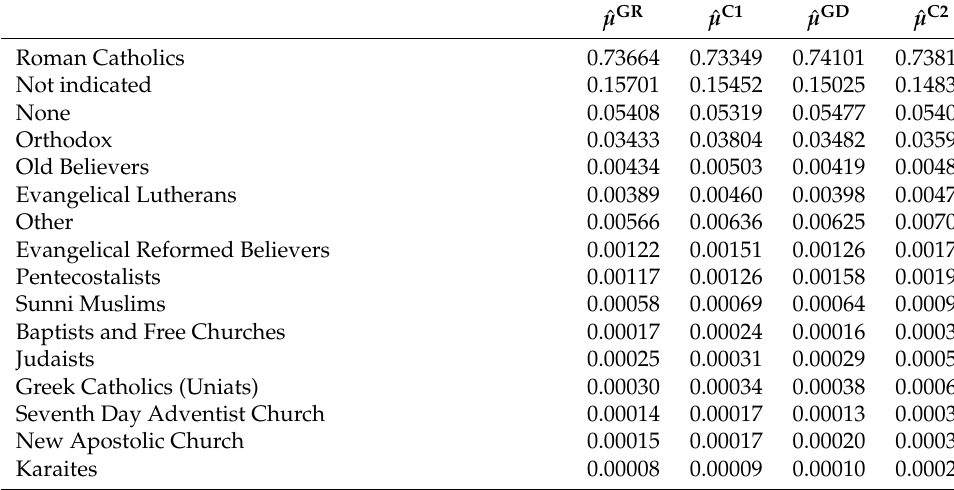
Table 4. Religion proportion estimates in 2021 census population.